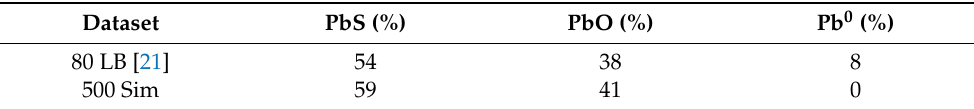
Table 3. XPS results comparing the relative presence of the three Pb species found for the two concentrations,